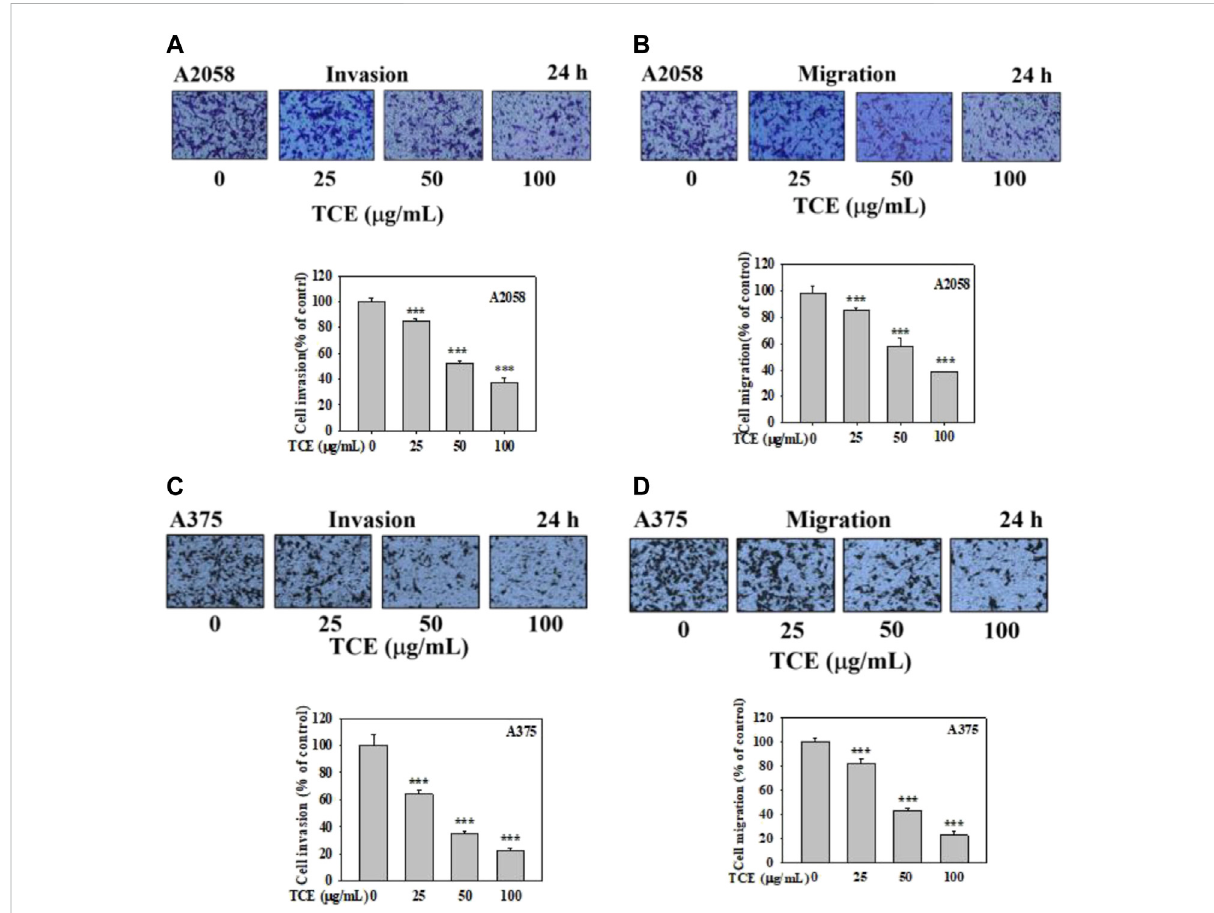
FIGURE 5 Effects of TCE on cell invasion and migration of A2058 and A375 cells. After being treated with TCE at a concentration of (0, 25, 50, 100 μ g/mL) for24h,cellinvasionandmigrationassaywerethenperformedasdescribedintheMaterialsandMethods.RepresentativeimagesofA2058andA375 cellsonthelowersideofmembraneatdifferenttimepointsinthe (A,C) invasionand (B,D) migrationassay.Arepresentativenumberofinvading cells through the Matrigel and membrane were counted under the microscope for 10 random fi elds at a 3,200 magni fi cation. The results